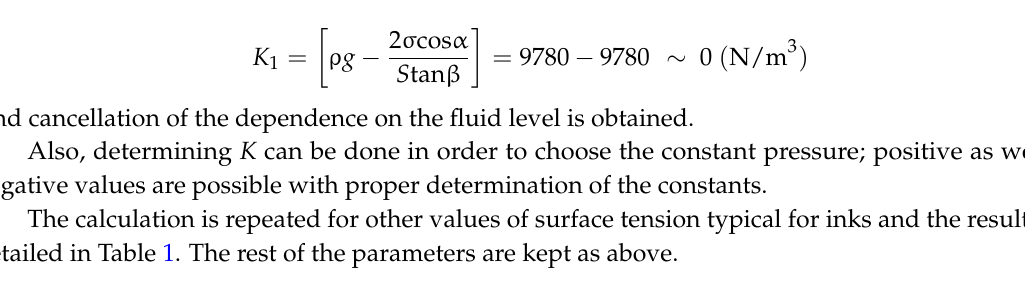
Table 1. Results for different surface tension